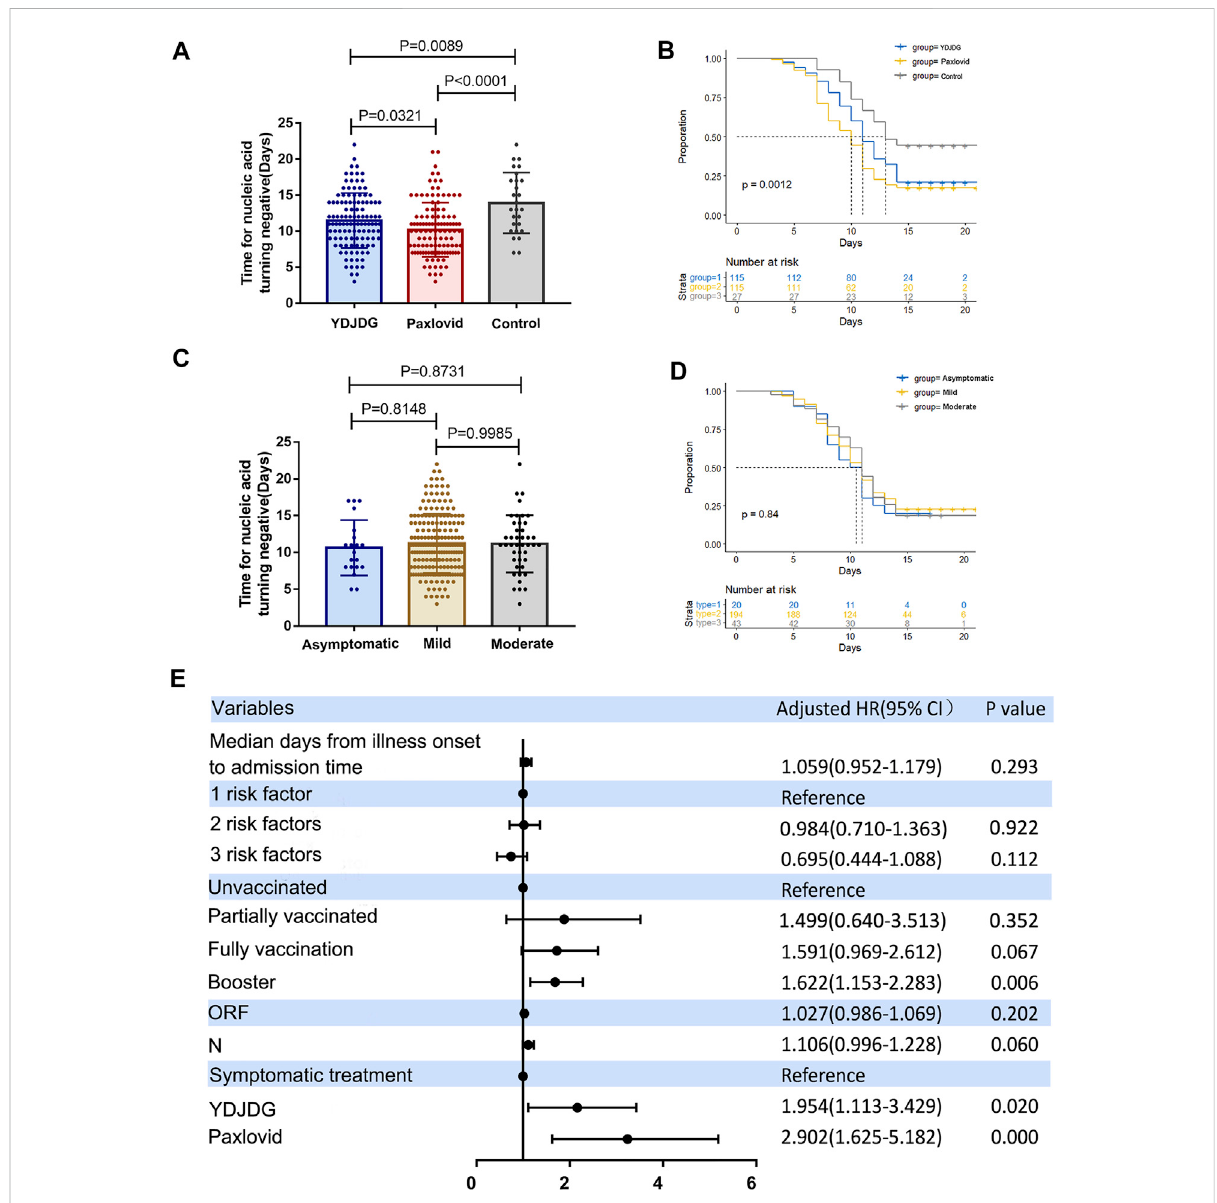
FIGURE 2 Analysis of 257 participants enrolled in the study. (A) The median SARS-CoV-2 nucleic acid shedding time was 10.21 days in the Paxlovid group, 11.49 days in the YDJDG group, and 13.93 days in the control group. (B) Signi fi cant differences were observed among the three groups in the SARS- CoV-2 nucleic acid shedding rate at 14 days ( χ 2 = 13.45, p = 0.0012). There was no statistical difference of nucleic acid shedding time (C) and shedding rate at 14 days (D) among patients with different disease types ( p > 0.05). (E) Cox regression analyses for nucleic acid shedding proportion in patients with COVID-19 after a follow-up of 14 days. Vaccine booster, YDJDG therapy, and Paxlovid therapy are signi fi cant factors affecting nucleic acid shedding ( p < 0.05). COVID-19, coronavirus disease-2019; YDJDG, Yindan Jiedu